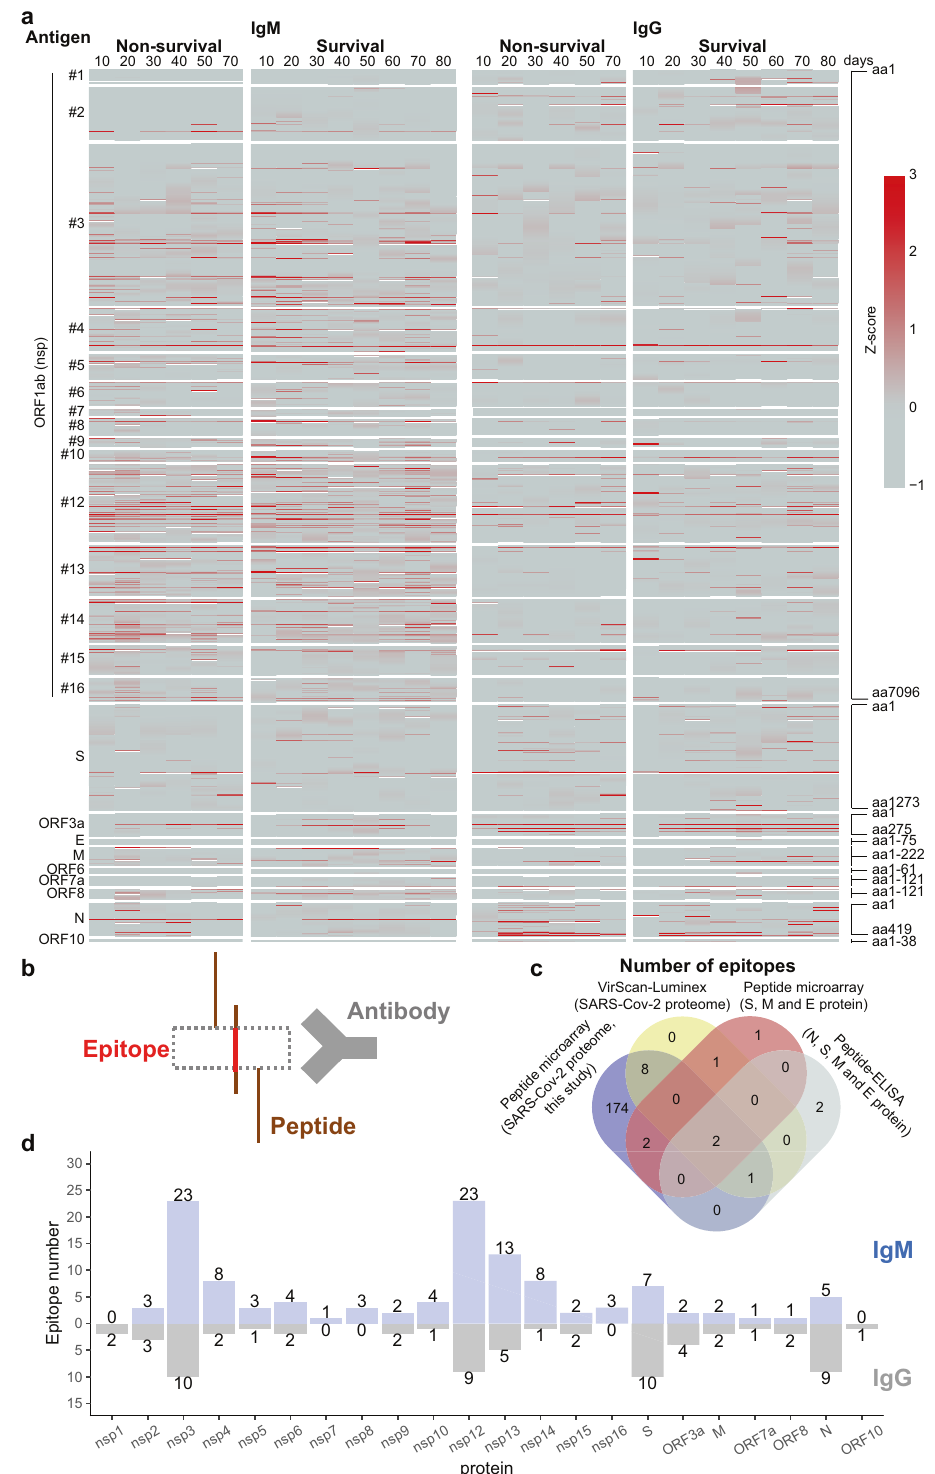
Fig. 2 Longitudinal changes of SARS-CoV-2 proteome antibodies in critical COVID-19 patients. a Longitudinal detection of SARS-CoV-2 IgM and IgG antibodies in critical COVID-19 patients. The raw data for each peptide and protein on the array were normalized to the z-score. The left y -axis represents the different SARS-CoV-2 proteins. The right y-axis represents the amino acids of each protein sequence, from the N-terminus (left) to C-terminus (right). The top x -axis shows the number of days post symptom onset in 10-day intervals. b Schematic illustration of epitope identi fi cation via epitope mapping. c Validation of reported peptide epitopes with data from this study. d Number of IgM and IgG peptide epitopes identi fi ed within each SARS-CoV-2